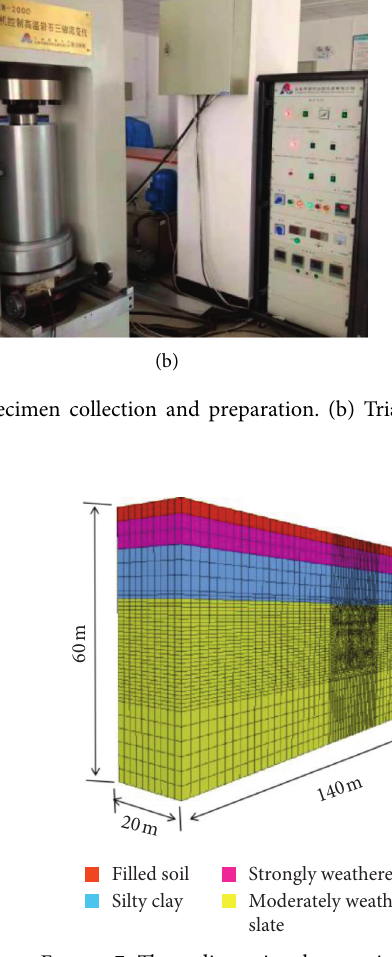
Figure 7: Three-dimensional numerical model.